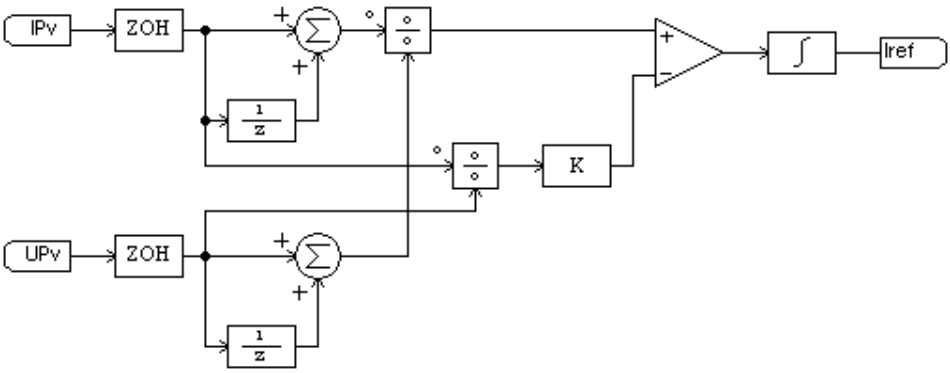
Figure 3. MPPT scheme based on the photovoltaic current ( I PV ) and voltage ( V PV ) measurements.